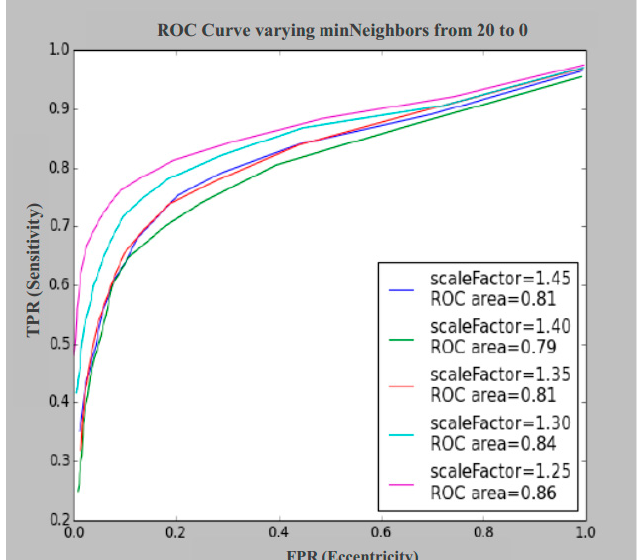
Figure 7. ROC (Receiver Operating Characteristic) curve for the Euro banknote for scale Factor=1.45, scale Factor=1.40, scale Factor=1.35, scale Factor=1.30 and scale Factor=1.25. FPR: false positive rate; TPR: true positive rate.